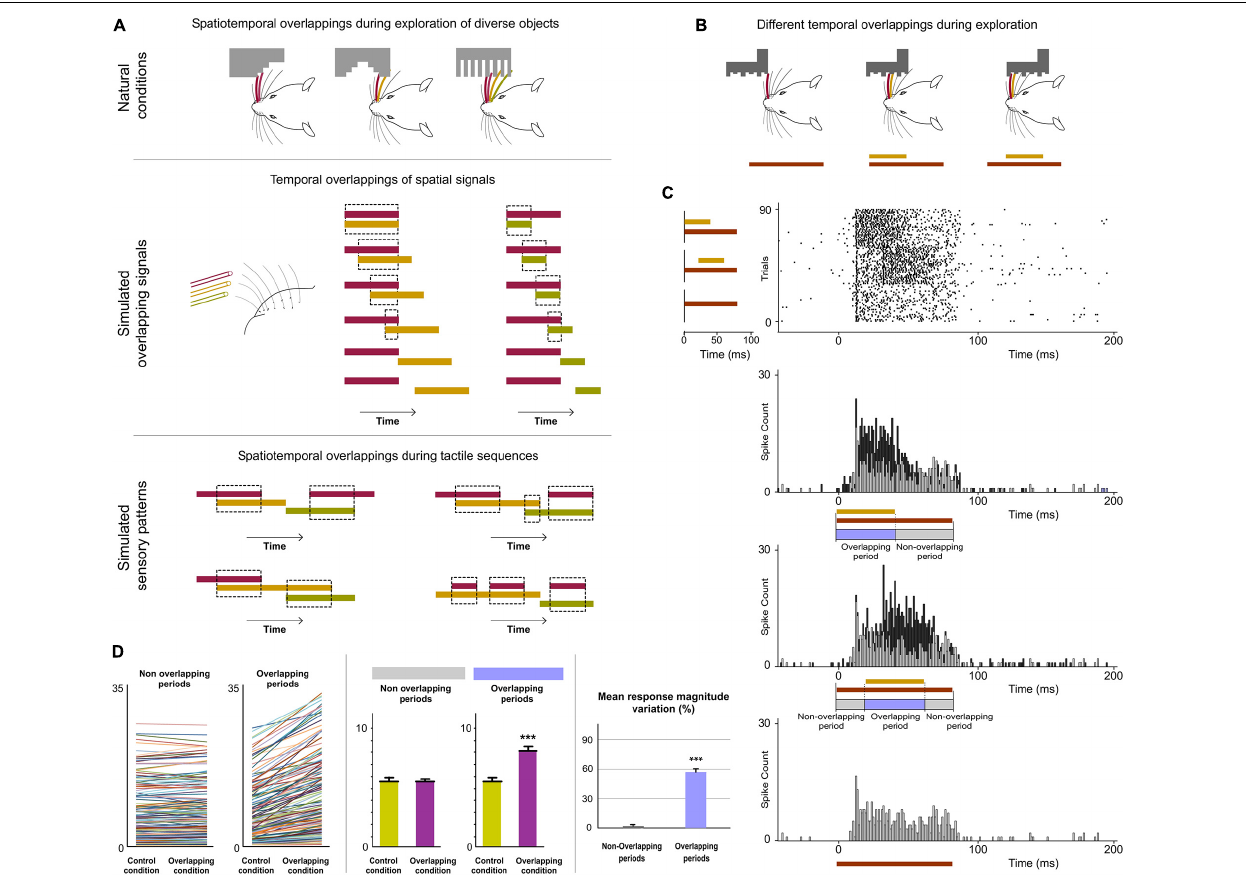
FIGURE 4 | POm integration of spatiotemporal overlapping dynamics. (A) Sensory patterns can be simulated by the simultaneous activation of different whiskers and by varying the number of whiskers stimulated, their combination and the order and duration of air pulses to produce different spatiotemporal overlappings. A variety of spatiotemporal patterns were designed to simulate possible real stimuli or sequences of stimuli using controlled multiwhisker deflections performed by overlapping air puffs of different durations applied to different whiskers including neighboring whiskers or whiskers farther apart across the whisker pad. The duration of air puffs and the temporal overlapping between them were varied to generate different combinations (protocols). The number of whiskers stimulated by each air puff was varied to generate different sensory patterns using the same protocol. Some examples are shown. Air puffs are represented by color lines. Their length reflects the duration of the signal. Temporal overlappings between sensory signals are highlighted. (B) Schematic illustration of a simulated tactile sequence reflecting the generation of different temporal overlappings. (C) Raster plots and PSTHs of representative POm responses evoked by temporal overlappings illustrated in the tactile sequence in panel (B) are shown. The appearance of a new signal during the presence of an existing signal was integrated by POm. This was reflected in precise increases in POm activity. These increases in sustained responses were only produced during the overlapping time between them (Overlapping period) but not during the non-overlapping time (Non-overlapping period of response). The duration of the Overlapping and Non-overlapping periods is indicated. Note that the increases in POm activity during overlapping periods were sustained along the temporal overlapping. (D) Plots comparing the spike rate of all recorded multi-units ( n = 155, depicted in different colors) during the Overlapping and Non-overlapping response periods in Control and Overlapping conditions across sensory patterns. The mean firing rate was increased in the Overlapping periods ( p < 0.001; Wilcoxon matched-pairs test) but not in the Non-overlapping periods where the mean magnitude of responses did not change ( p = 0.43; Wilcoxon matched-pairs test). Response magnitude variation (%) between Control and Overlapping conditions in Non-Overlapping and Overlapping periods ( p < 0.001, Wilcoxon matched-pairs test) is also shown. *** P <